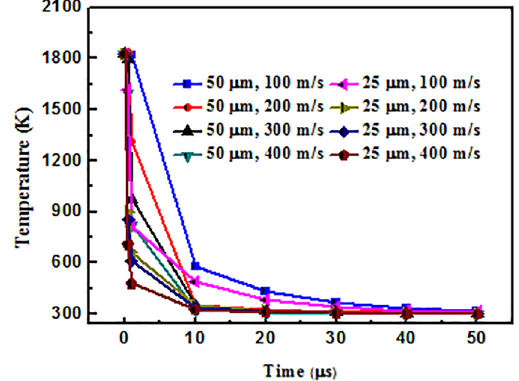
Figure 9. Relationships between droplet solidification temperature and impact times.